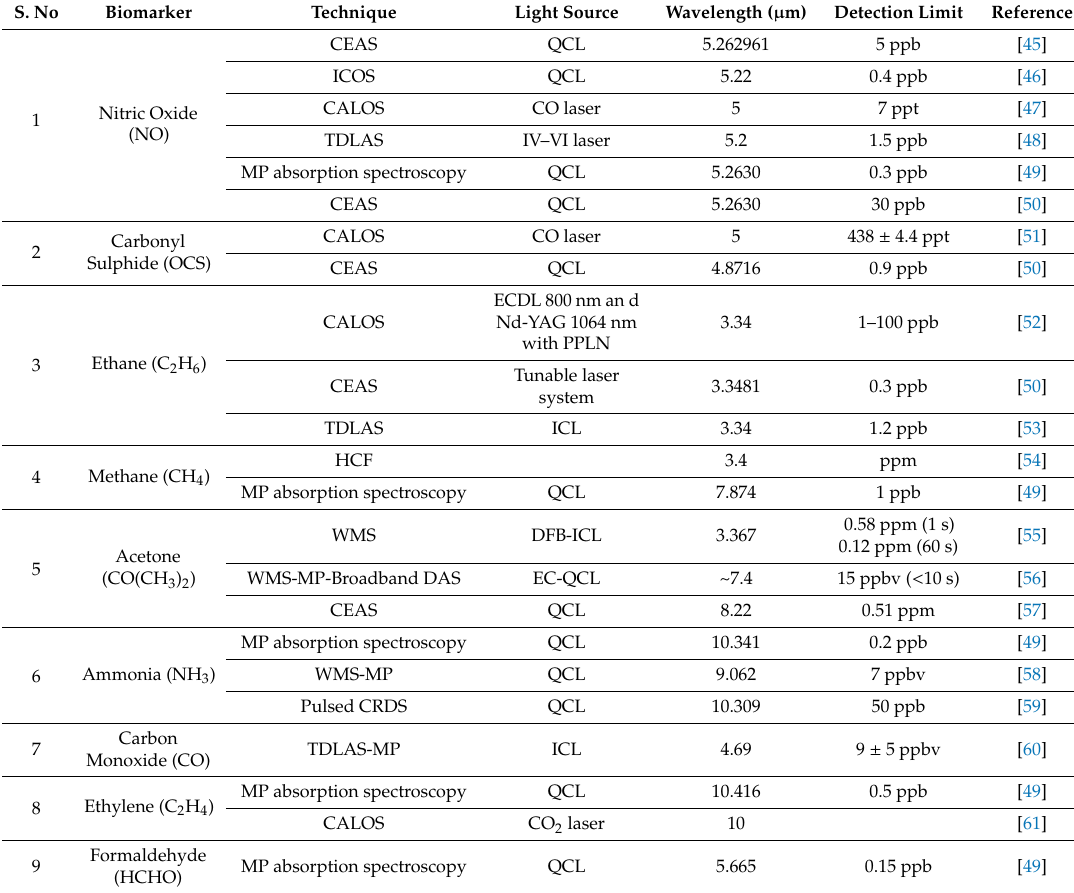
Table 2. Spectral fingerprints, laser techniques employed, and detection limit of select few